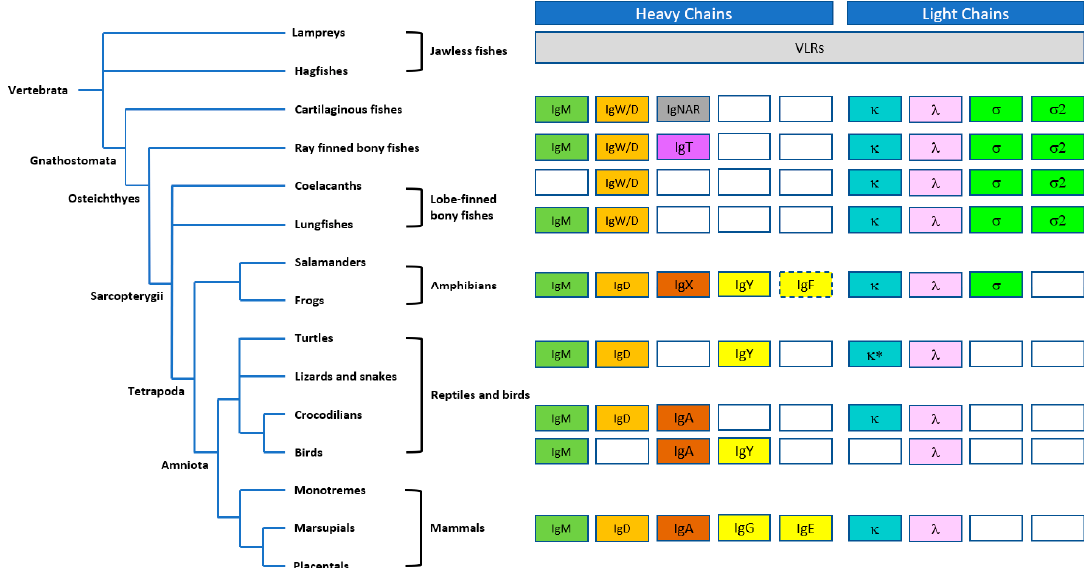
Figure 2. Schematic diagram illustrating the evolution of immunoglobin (Ig) heavy and light chain isotypes in vertebrates, with the IgM isotype broadly represented across phyla. Antigen-binding variable lymphocyte receptors (VLRs) in jawless fishes (agnathans) are thought to be precursors of immunoglobulins. The IgW isotype in cartilaginous fishes is orthologous to IgD in other groups; IgNAR is a “new antigen receptor” isotype, identified in nurse shark, that does not associate with light chains and does not have an ortholog in higher species. IgT appears to be the most ancient Ig specialized for mucosal protection. IgX, originally identified in Xenopus is orthologous and functionally analogous to IgA. IgY is the amphibian, reptilian, and avian equivalent of IgG and IgE. IgF only has two constant domains but has homology to IgY. Open boxes represent the lack of certain heavy or light chains in the certain vertebrate lineages; dashed boxes represent a common ancestry; and * represents the lack of κ light chain in snakes. Figure adapted from Pettinello and Dooley 2014 [22] and Kaetzel 2014 [23].